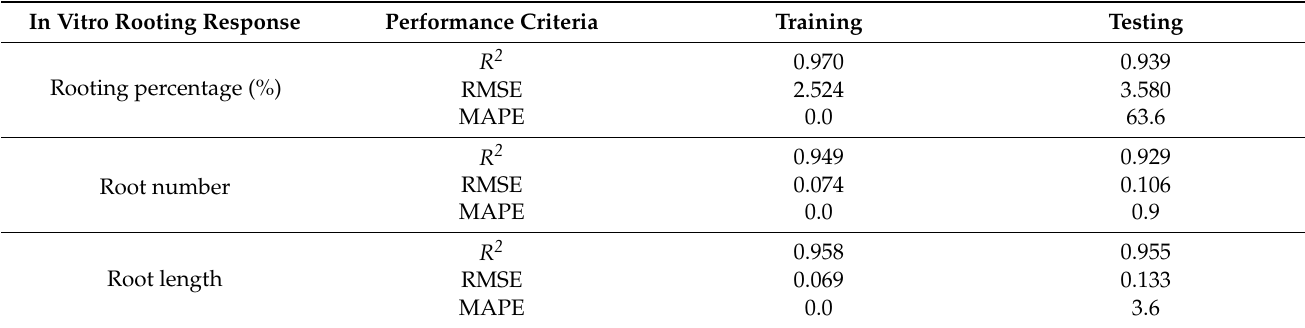
Table 2. Performance criteria of GRNN model for in vitro rooting of P. caerulea in training and testing sets.